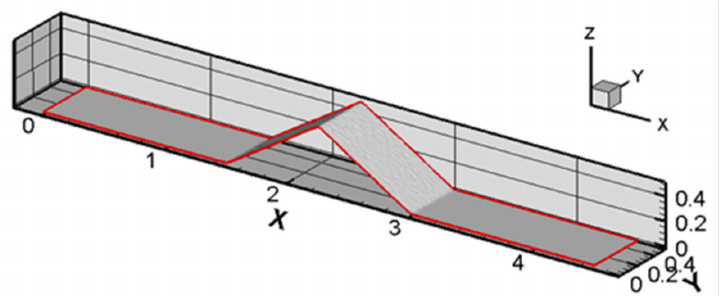
Figure 8. The geometry of the NWT in the test of flow passing barrier and stability above the barrier level.